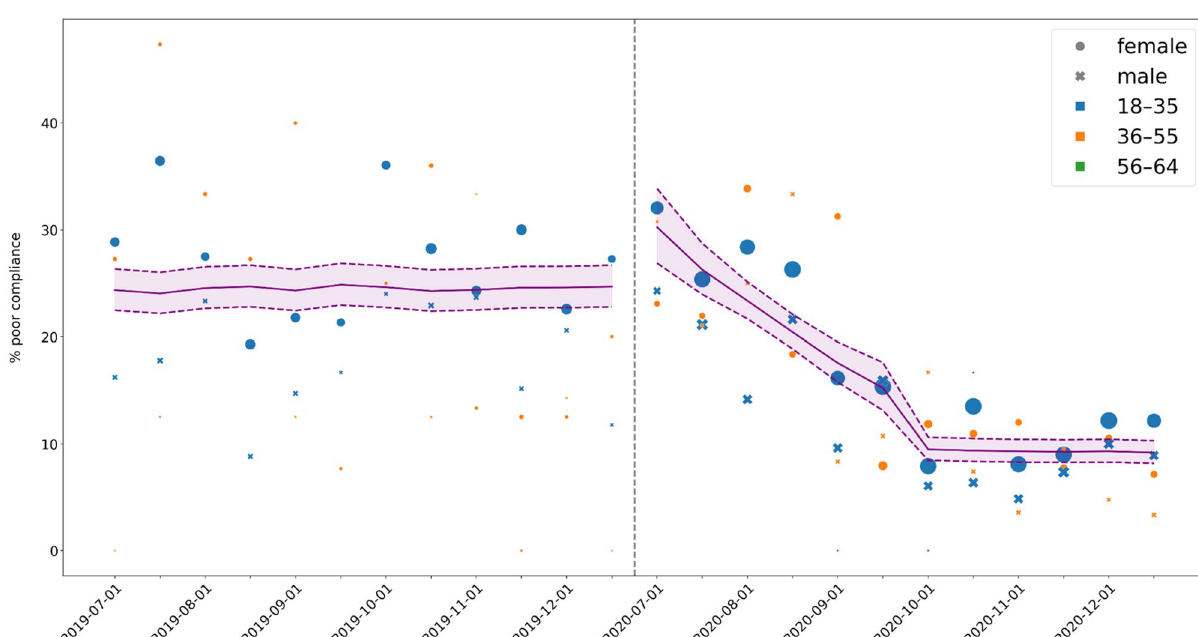
Figure 5. The MMI model by starting date of treatment. The purple line gives the point estimates of expected poor compliance while the purple shaded area is the 95% confidence band. Each point indicates the mean poor compliance of the given group, whereby the size of the point is proportional to the number of patients contained within that group. Points with fewer than 5 patients were excluded from the figure. The dashed vertical line indicates the gap between the two